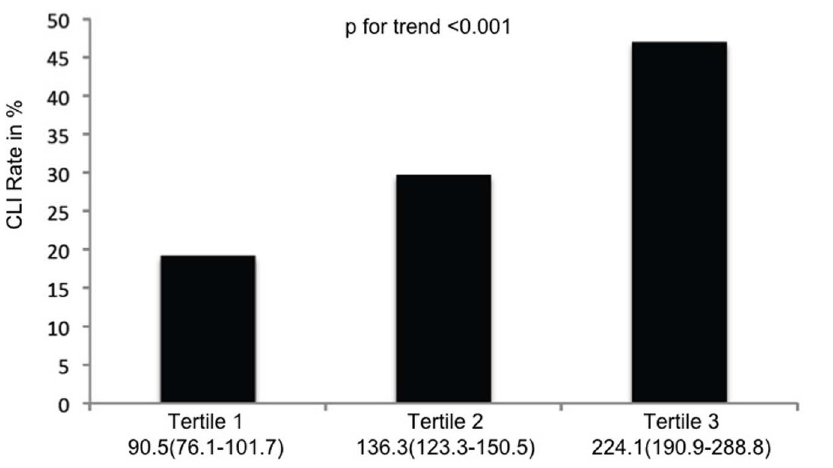
Figure 1. Percentage of patients with CLI stratified by tertiles of PLR. Numbers below the figure are median PLR and the 25 th and 75 th percentile.